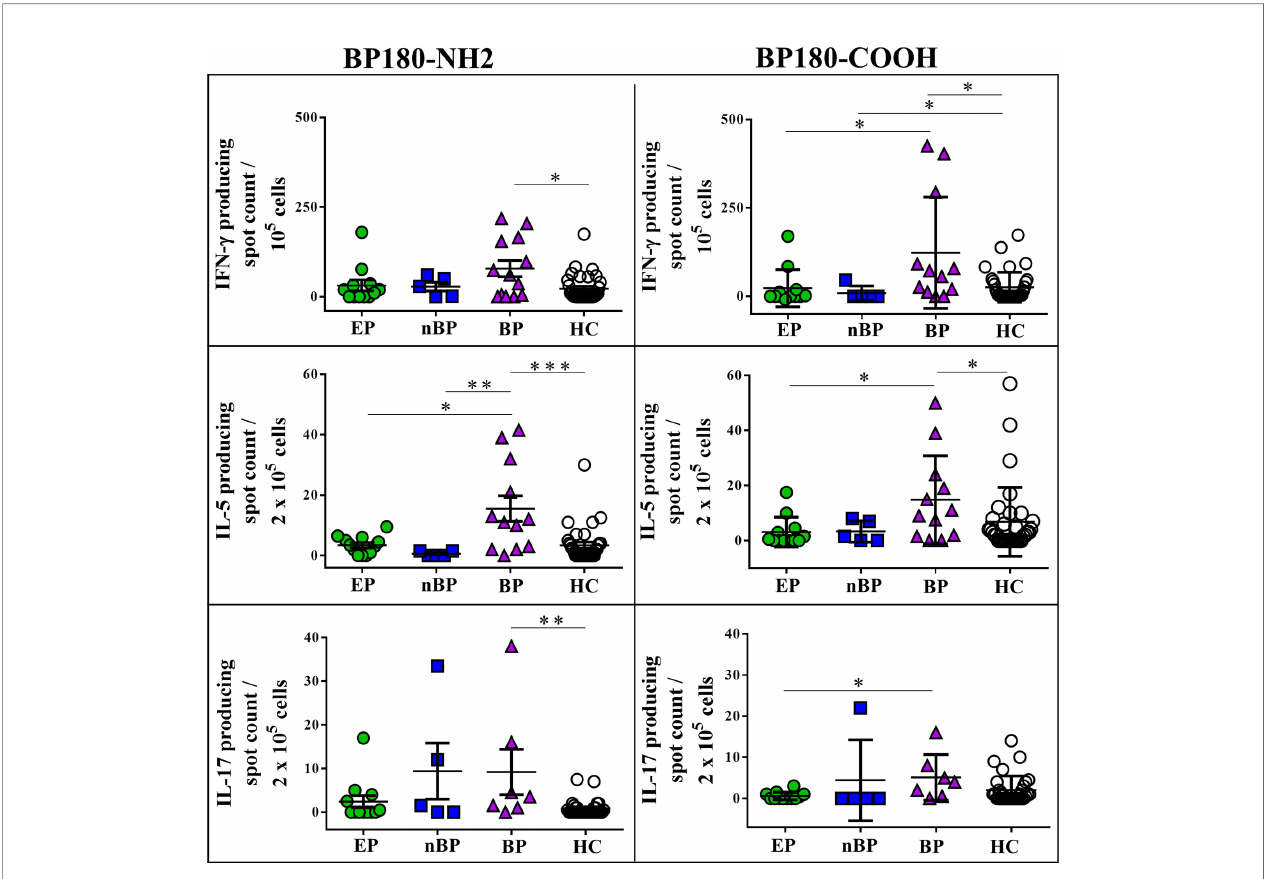
FIGURE 2 | Peripheral blood T cell responses against bullous pemphigoid (BP) 180 in elderly patients with pruritic disorders (EP), non-bullous pemphigoid (nBP), and healthy controls (HC). Shown are cytokine secreting T cells, producing IFN- g , IL-5 or IL-17 upon ex vivo stimulation with the immunodominant NC16a domain of BP180 (BP180-NH2) or the COOH terminus of BP180 (BP180-COOH). Differences between the groups were analyzed using Mann-Whitney U-test (*P < 0.05, **P < 0.01, ***P <